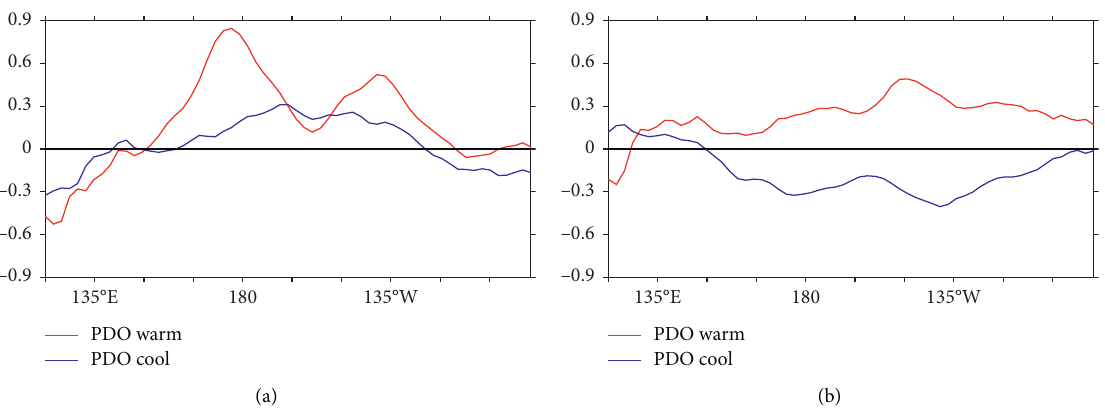
Figure 13: Zonal distributions of the composite winter (November-March) mean tropical surface zonal wind anomalies in developing (a) and decaying (b) CP El Niño years during the warm PDO (red line) and cool PDO (blue line)